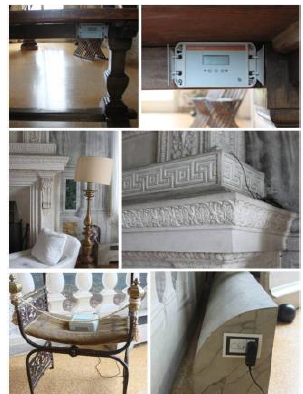
Figure 2. Beesper Bridge in the room “Croce Centrale” (top photos); Beesper Node in the room “Stanza del Tribunale d’Amore” (central photos); Beesper Node in the room “Croce Centrale” (bottom